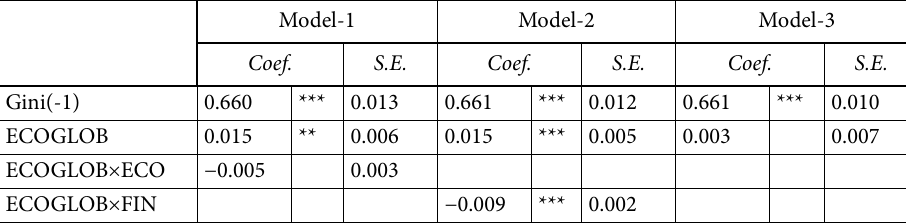
Table 3. The effects of economic globalization under separate aspects of country